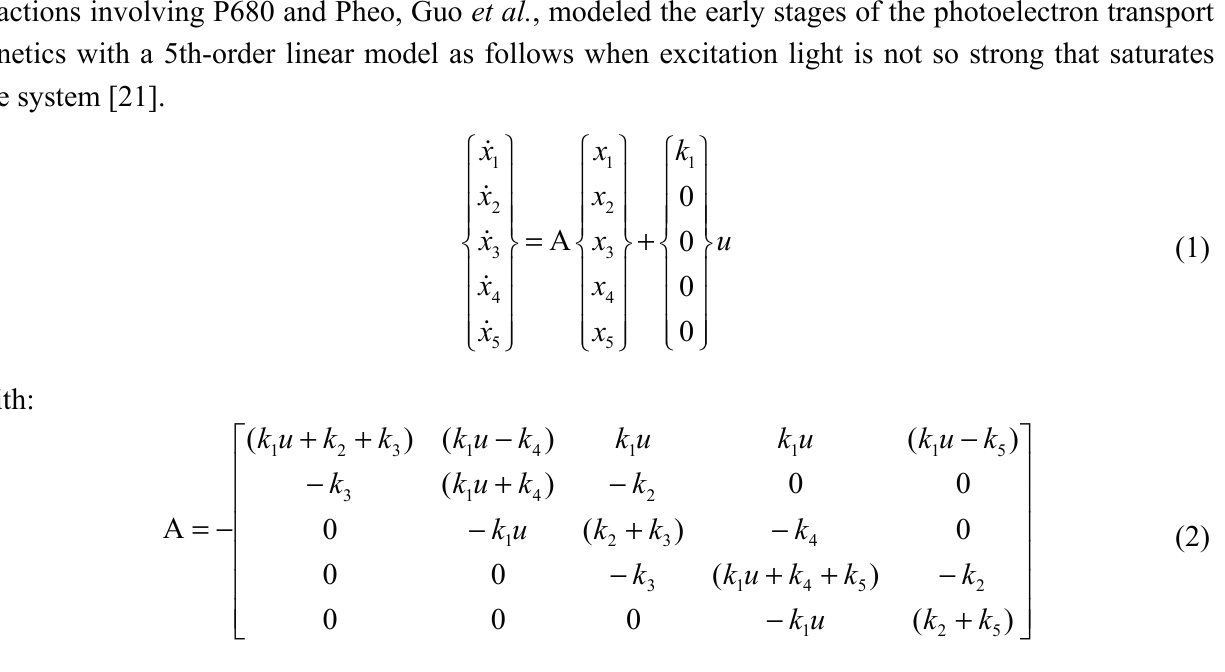
Figure 6. Early stages of the PSII photoelectron transport